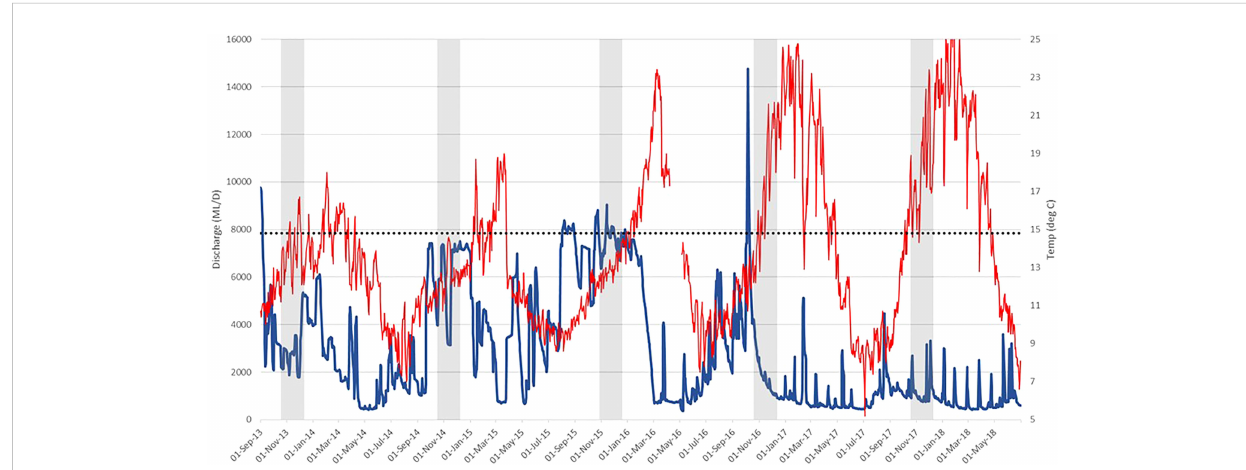
FIGURE 2 Average daily discharge (blue) and water temperature (red) data for the lower Mitta Mitta River during the core study period from 2013 – 2018. Dotted horizontal line = egg and larval survival threshold of 14.8°C (50% survival as predicted by Todd et al., 2005). Vertical grey bars represent core egg and larval period for Murray cod.